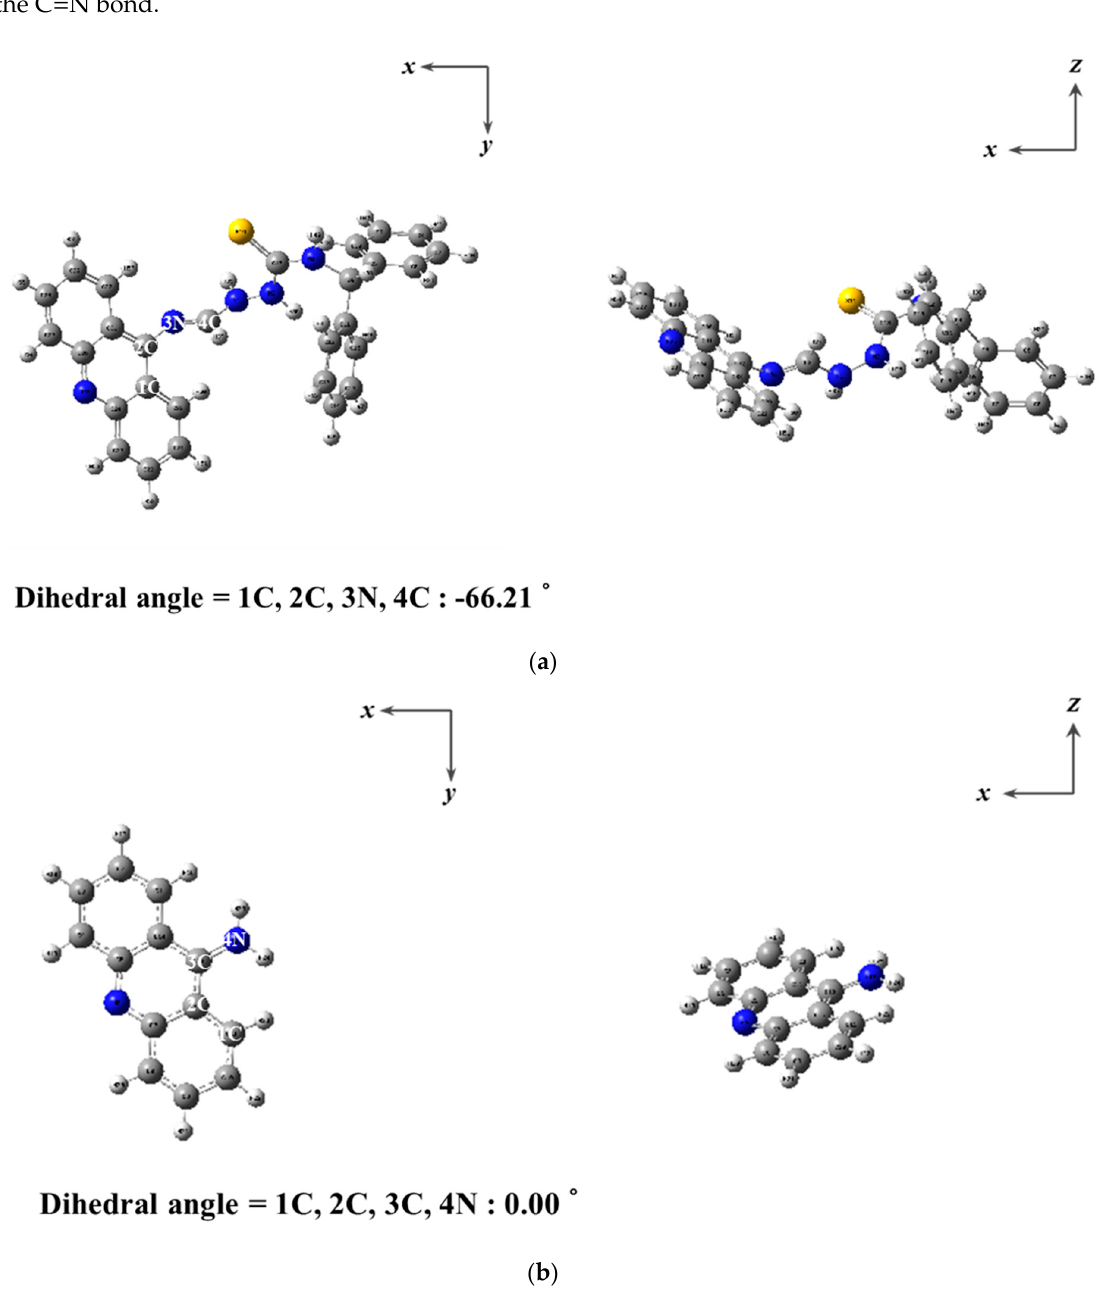
Figure 5. Energy-minimized forms of ( a ) BK and ( b ) 9-aminoacridine ( ACR ).